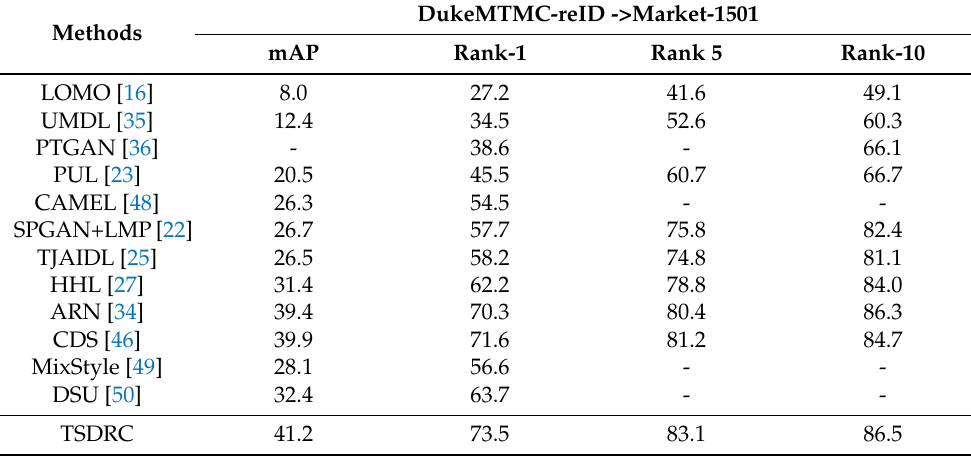
Table 5. Comparing TSDRC with other unsupervised domain-adaptive person ReID approaches on DukeMTMC-reID and Market-1501 datasets.